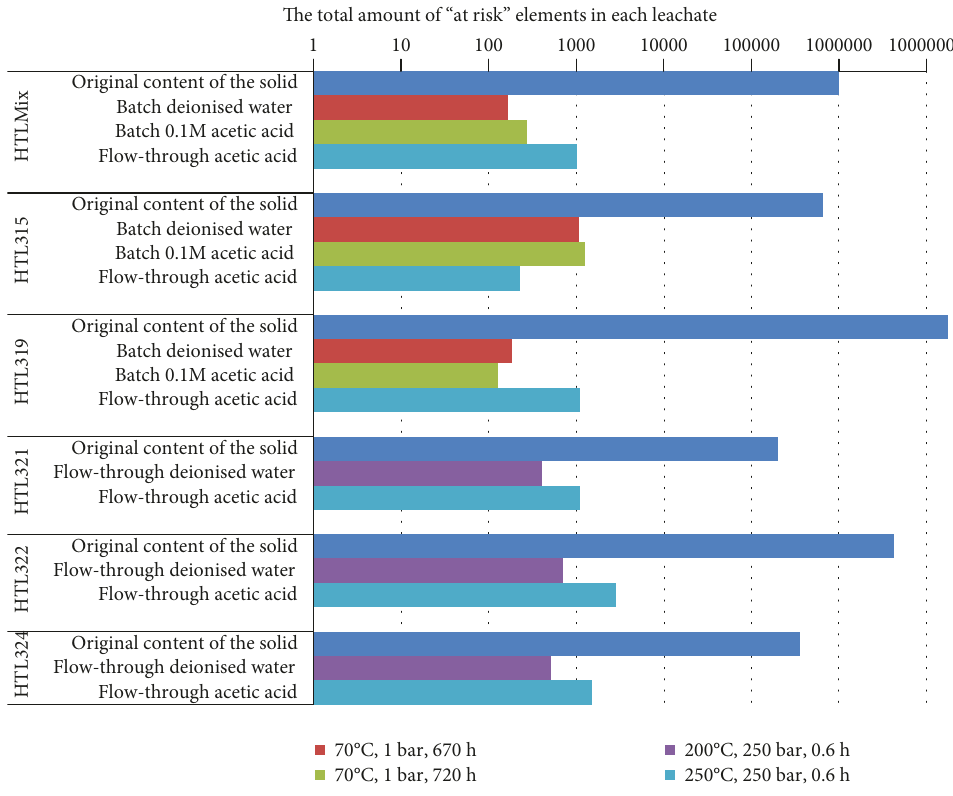
Figure 23: Summarising chart of detected “ at risk ” elements during each experiment with concentrations in